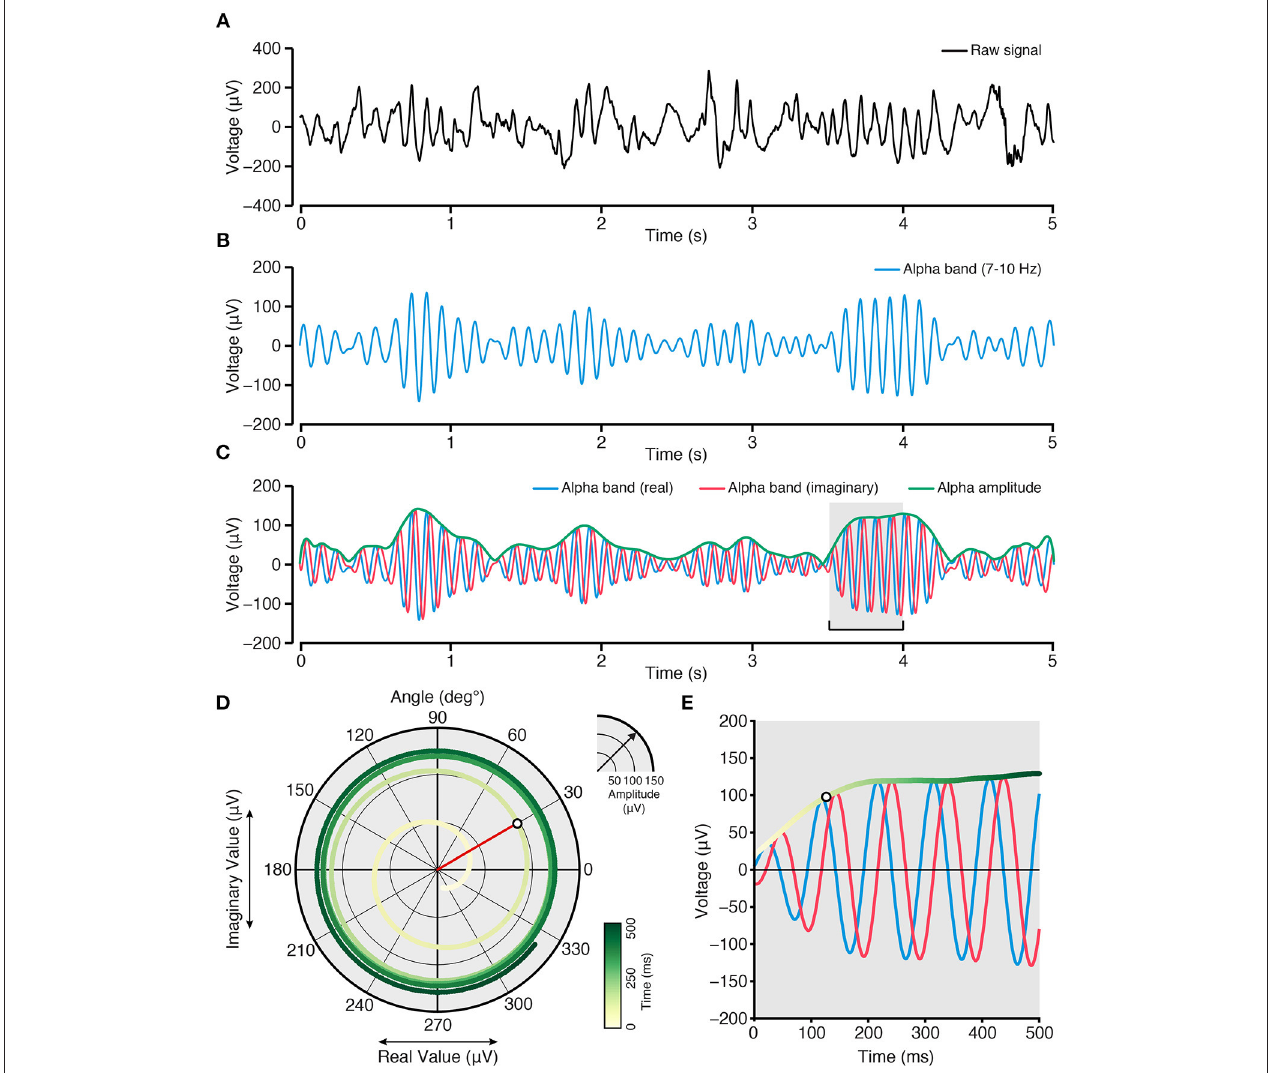
FIGURE 1 | Quantifying band limited amplitude for correlation analysis of spontaneous data. (A) Raw spontaneous ECoG time series (5s). (B) Spontaneous alpha band limited time series extracted from (A) , by a 7–10Hz band pass filter. (C) Analytic signal of (B) , obtained via a Hilbert transform, showing the real component (blue), imaginary component (red), and amplitude/envelope (green). The real component is the original band pass signal from (B) , and the imaginary component is a 90 ◦ rotated instantiation of (B) . The amplitude/envelope (green) is the absolute value of the analytic signal (i.e., a complex valued time series with real and imaginary parts). (D) Complex plane showing the temporal evolution (yellow-green shading) of the analytic signal [data comes from window highlighted with gray in (C) ]. Over time, each observation (sample) takes a coordinate location in the complex plane given the real (x-axis) and imaginary (y-axis) values at that time point [example time point with white fill color highlighted in (D,E) ]. For any given time point, the amplitude/envelope of the signal in the complex plane is defined by the vector length extending from the central zero axes to the real/imaginary coordinate (red line). For example, as time evolves in (D ; progress toward dark green) the trajectory of values spirals out radially, increasing the vector distance from the origin: this reflects an increase in alpha band amplitude as shown in (E) . Phase can also be obtained by identifying the angular position of the amplitude vector at each time point (red vector shown has a phase angle of 30 ◦ ). Other time frequency methods (filter-Hilbert approach shown here) can be employed, such as Wavelet convolution to achieve comparable results (Bruns, 2004; Cohen,